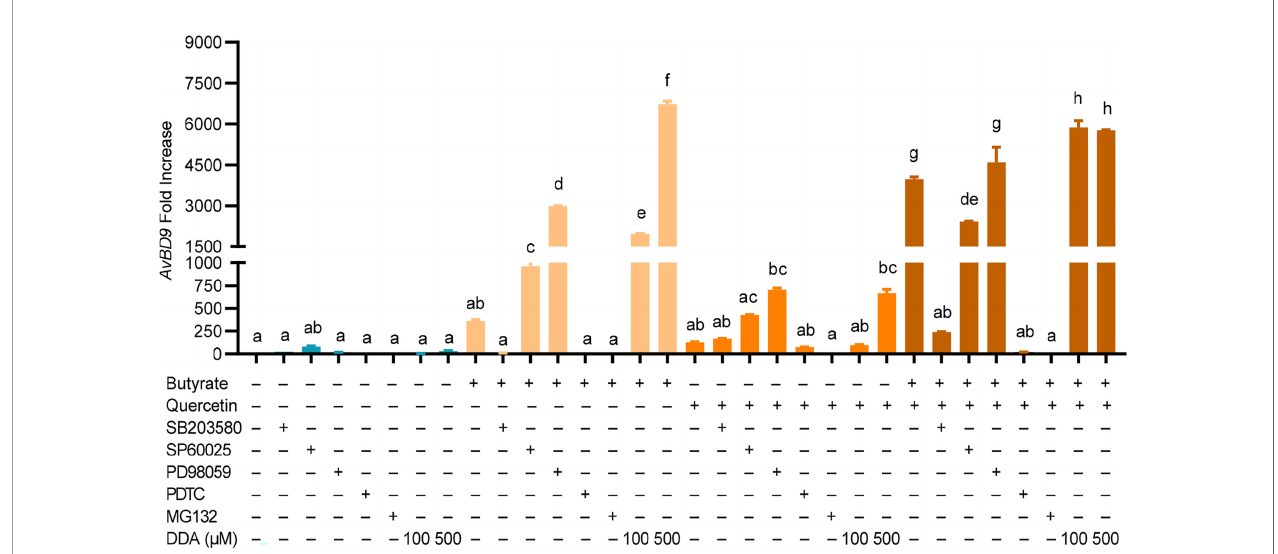
FIGURE 8 | Role of MAPK, NF- k B, and cAMP signaling pathways in AvBD9 induction mediated by quercetin and butyrate. Chicken PBMCs were pretreated for 1 h with or without 25 µM SB203580 (p38 MAPK inhibitor), 20 µM SP60025 (JNK inhibitor), 50 µM PD98059 (MEK1/2 inhibitor), 40 µM PDTC (NF- k B inhibitor), 20 µM MG132 (NF- k B inhibitor), or 100 or 500 µM 2 ’ ,5 ’ -dideoxyadenosine (DDA) (cAMP inhibitor), followed by stimulation with 10 µM quercetin with or without 2 mM sodium butyrate for another 24 h. RT-qPCR was performed to determine AvBD9 mRNA expression. Results are presented as means ± SEM of two independent experiments. The bars not sharing common superscript letters are signi fi cantly different ( P < 0.05) as determined by one-way ANOVA and post hoc Tukey ’ s